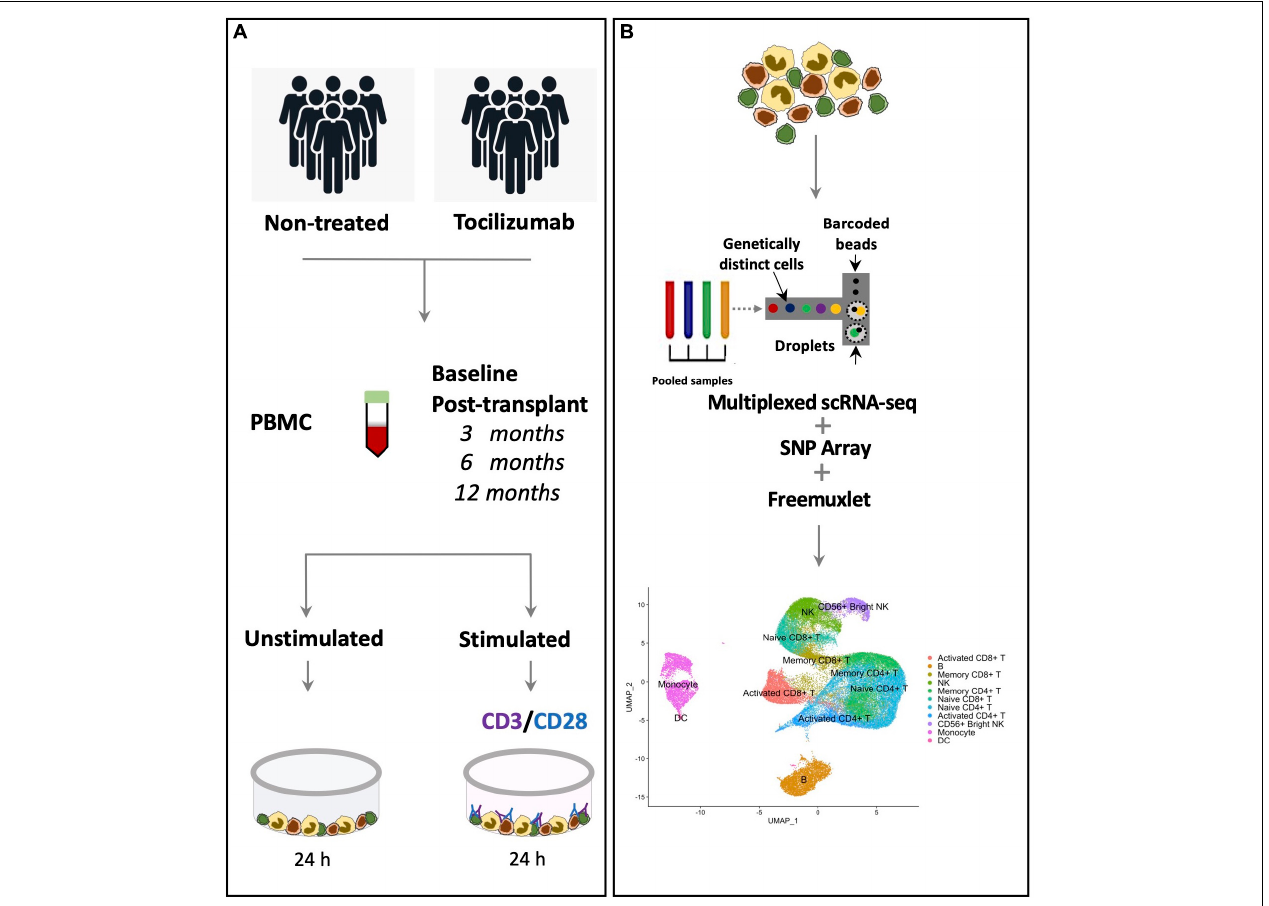
FIGURE 1 | Experimental design layout. (A) Experimental design showing treatment groups, collection of PBMCs at study baseline, then 3, 6, and 12 months post-treatment, and in vitro stimulation of PBMCs with CD3/CD28 stimulating antibodies. (B) Multiplexed droplet scRNA-seq and SNP array of PBMCs, with application of freemuxlet tools for demultiplexing and patient assignment, with eventual downstream cell clustering and annotation.